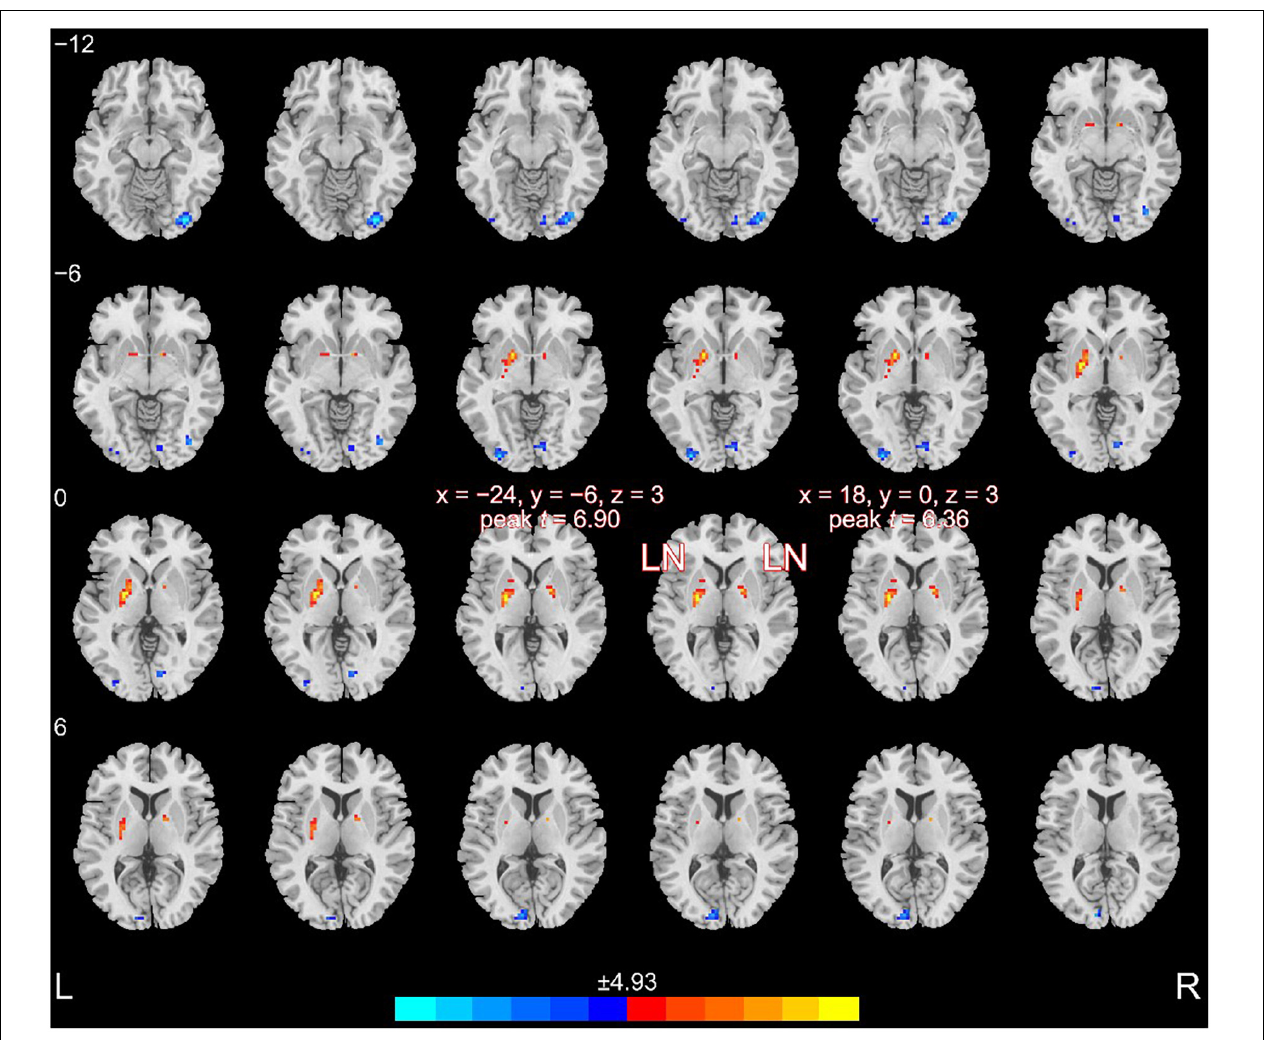
FIGURE 2 | Altered fALFF in patients compared to healthy controls. Patients with schizophrenia exhibited increased fALFF in the bilateral LN.